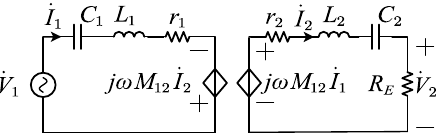
Figure 2. Equivalent circuit of the S/S compensated converter.